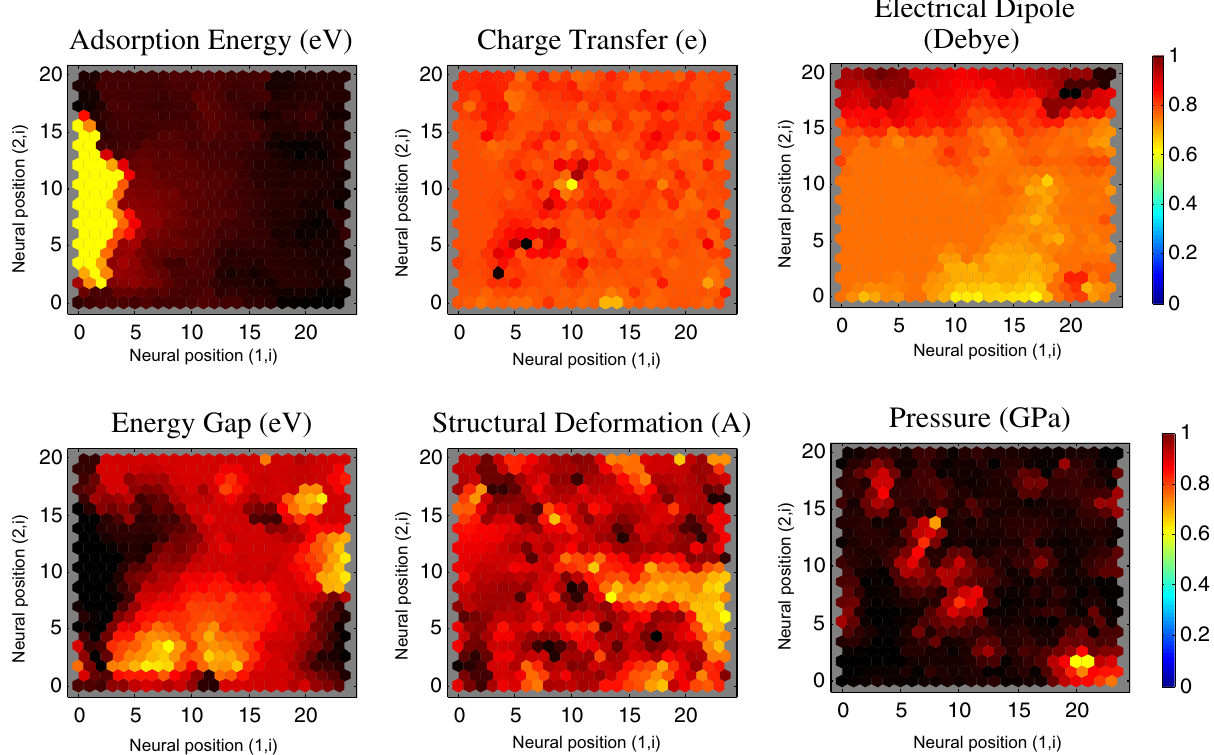
Figure 3. Neural networks analysis. The active feedback between the DFT results of 4-block 1D chain polymer adsorbed on graphene (CPs/GE) and neural network (NN) interpretation by self-organization automatic data interpretation. The adsorption energy and energy gap have reverse gradient color, then highly